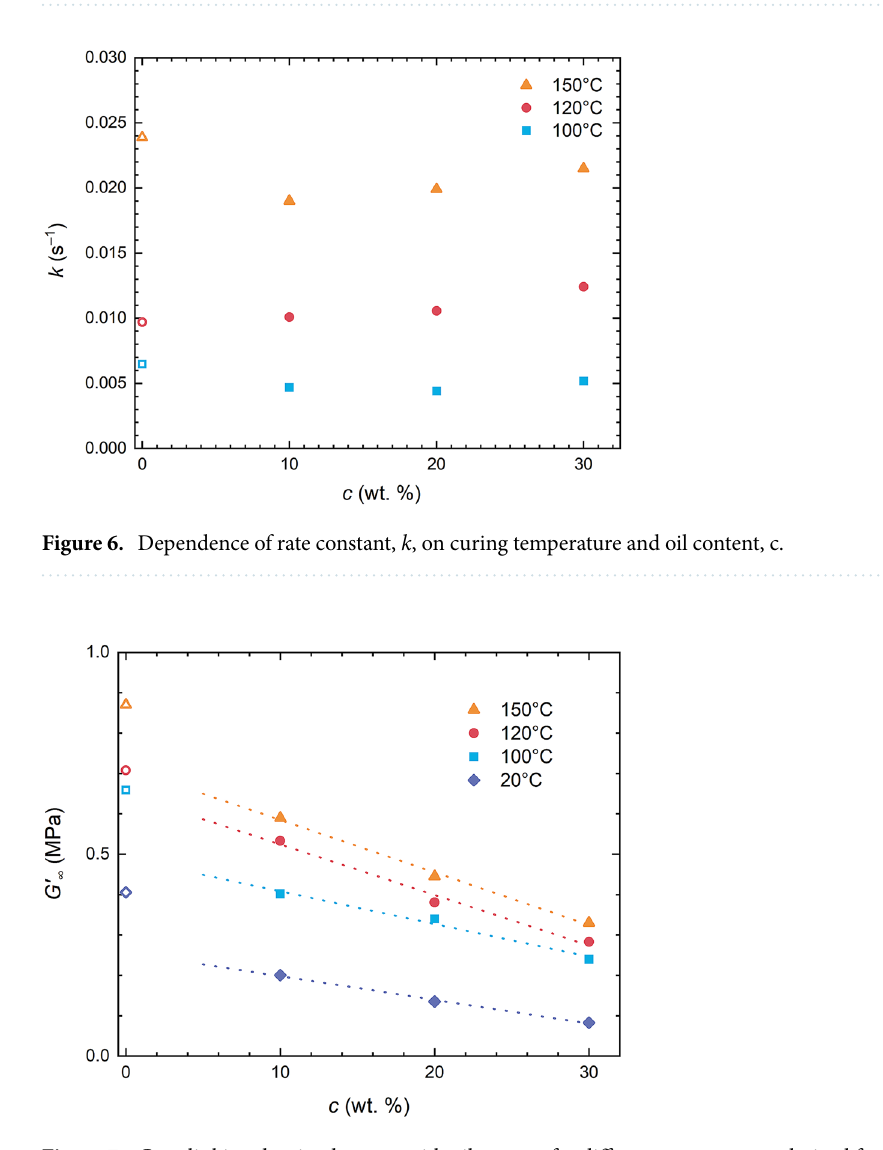
Figure 7. Crosslinking density decrease with oil content for different temperatures derived from rheological